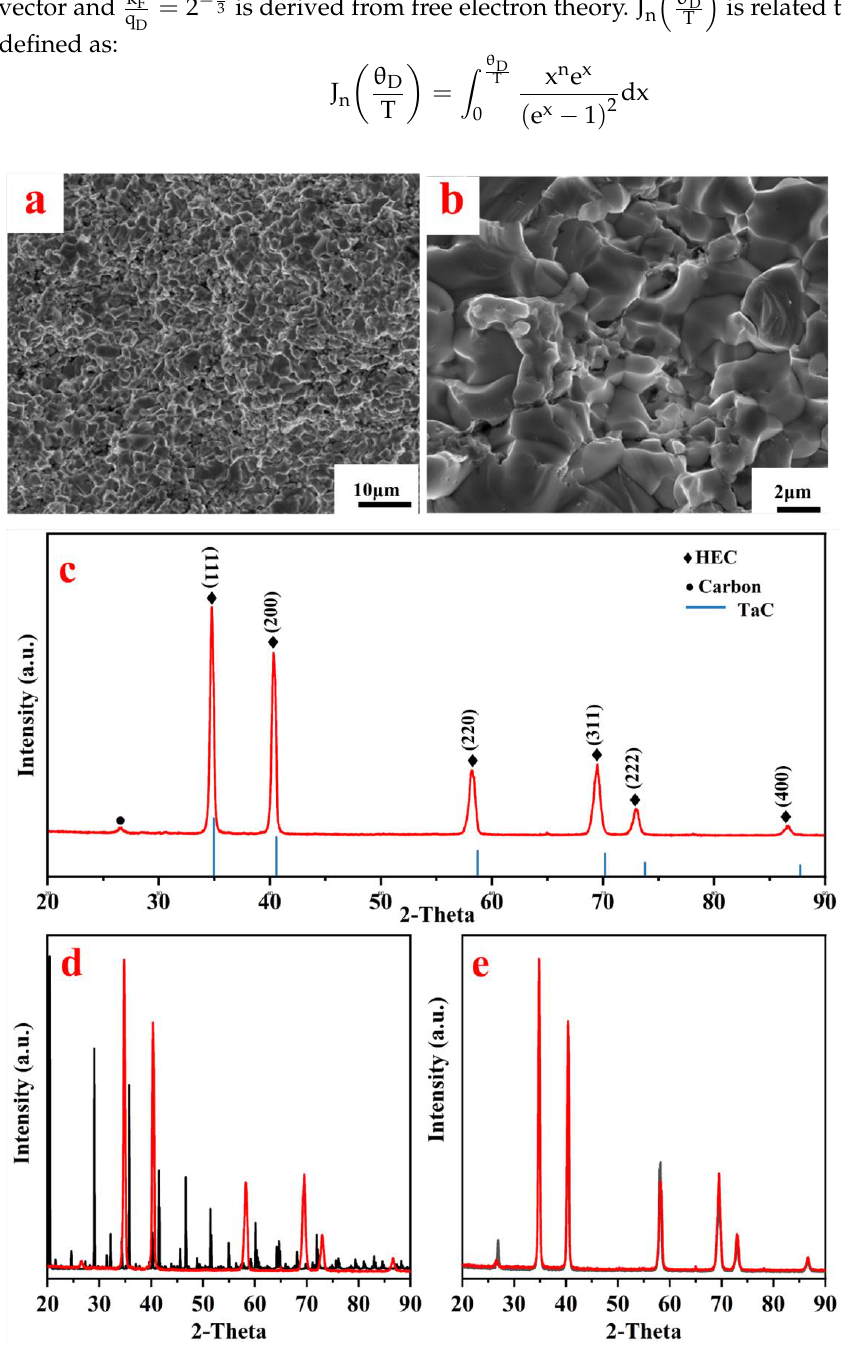
Figure 1. ( a , b ) SEM image of the HEC at different scales; ( c ) XRD patterns of the HEC and TaC; comparison of the experimental (red) and calculated (black) XRD patterns of the high−entropy car−bide; ( d ) before geometry optimization; ( e ) after geometry optimization.